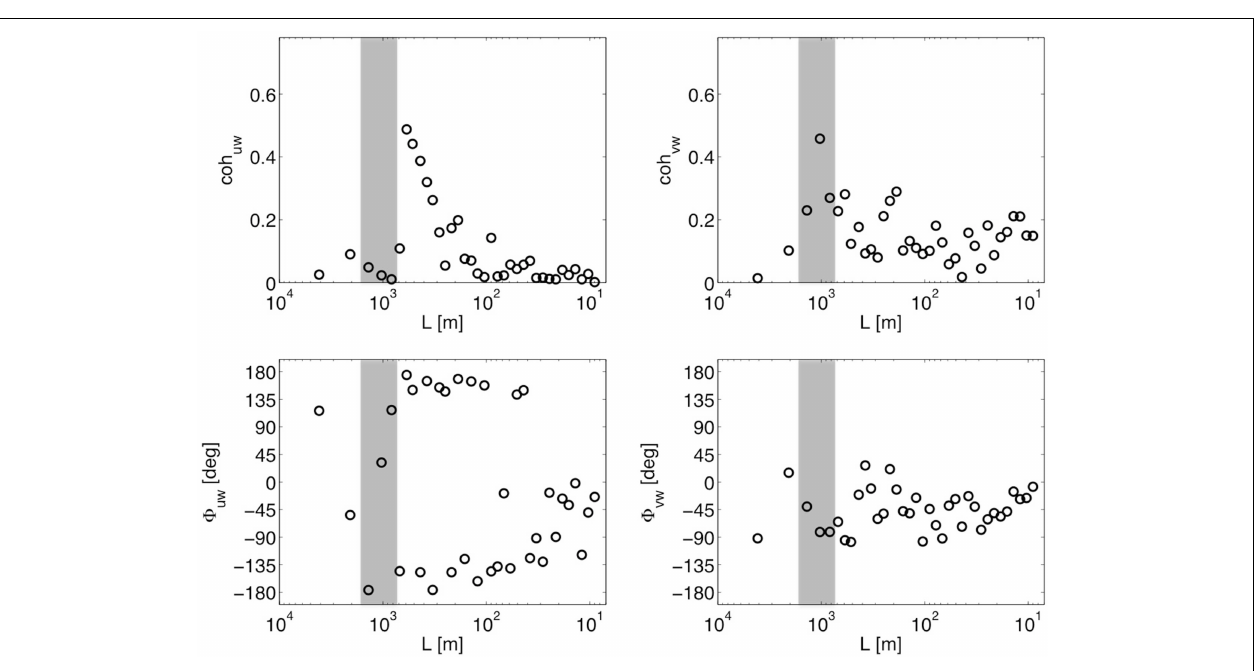
FIGURE 6 | Spectral coherence (top) and phase angle (bottom) between u and w (left) and v and w (right) wind components over the analyzed segment (44.90–45.05 ◦ N) at the upper ABL flight leg